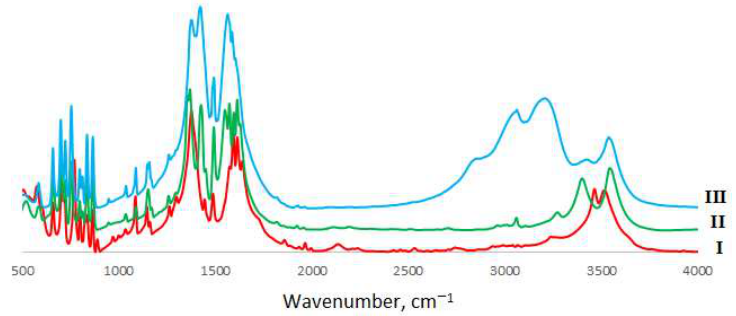
Figure 3. Mid-IR spectra of o -phthalatocuprates.